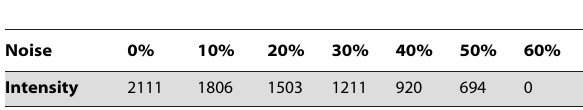
Table 3. Positive peak mean values for several noise levels